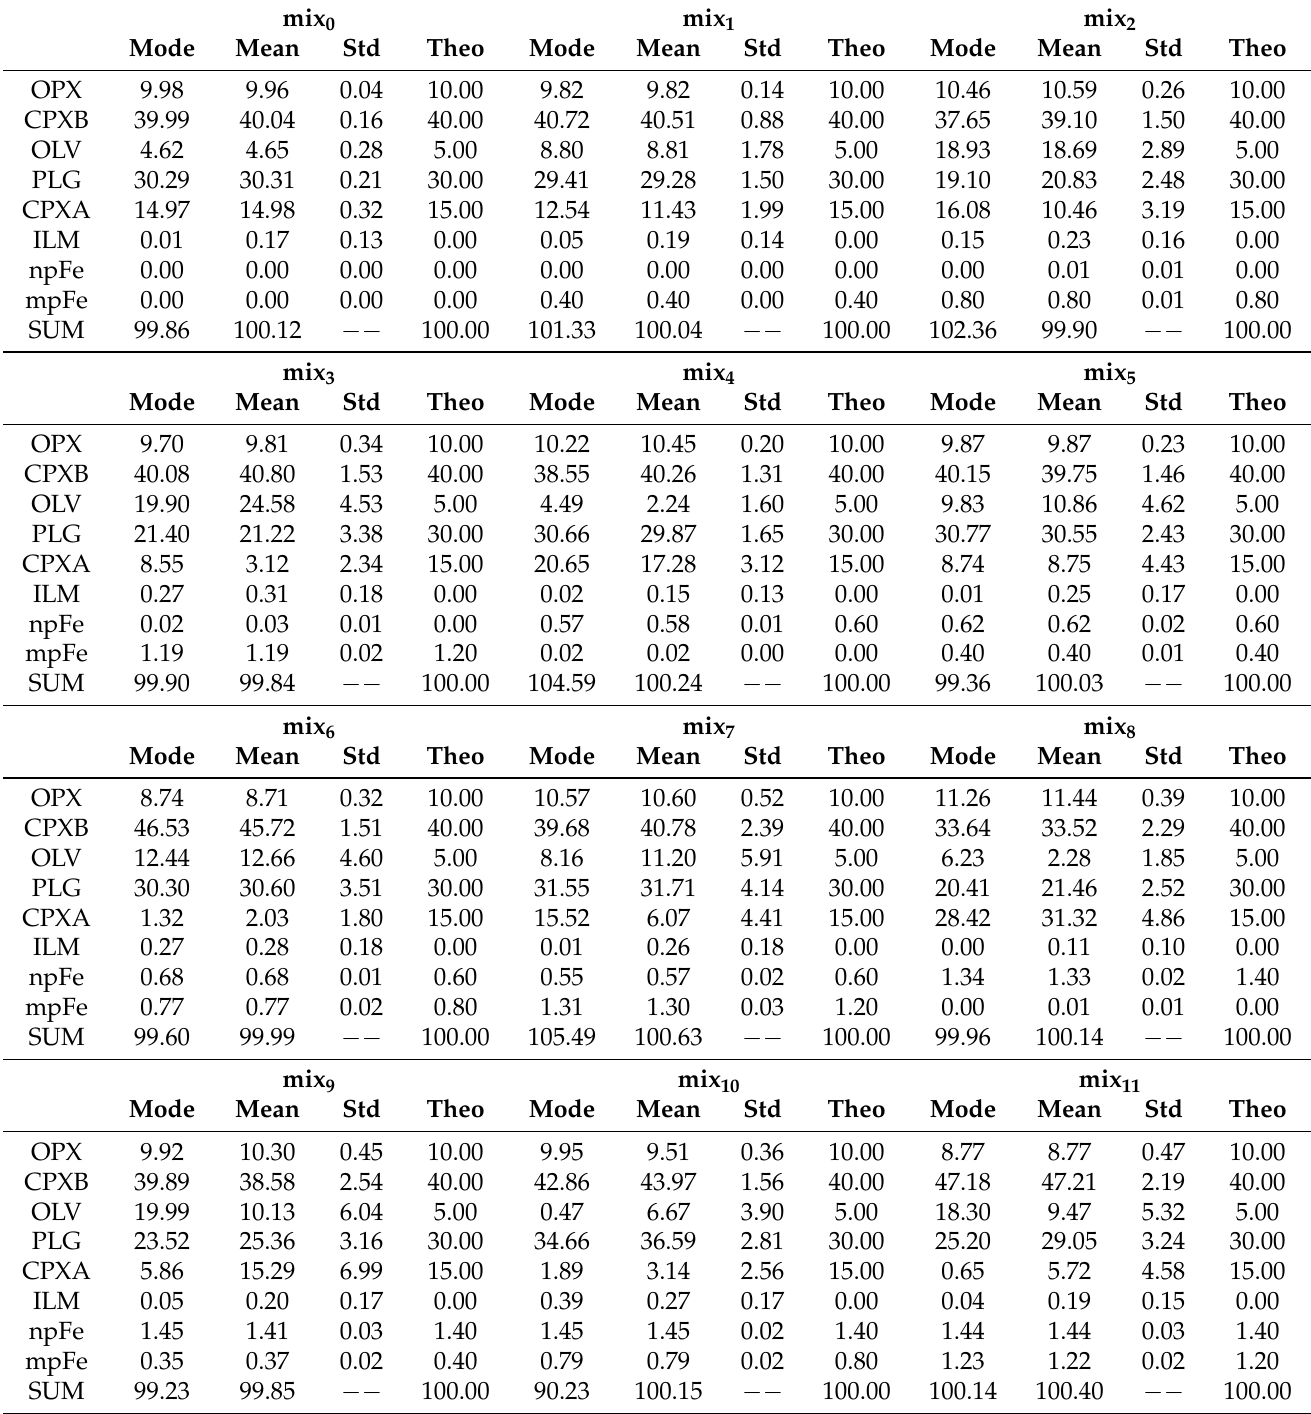
Table A4. Detailed results for the unmixing of the synthetically generated by using the forward mixing model. A prior on the TiO 2 and the Al 2 O 3 was set with α elem = 40. All results are displayed in